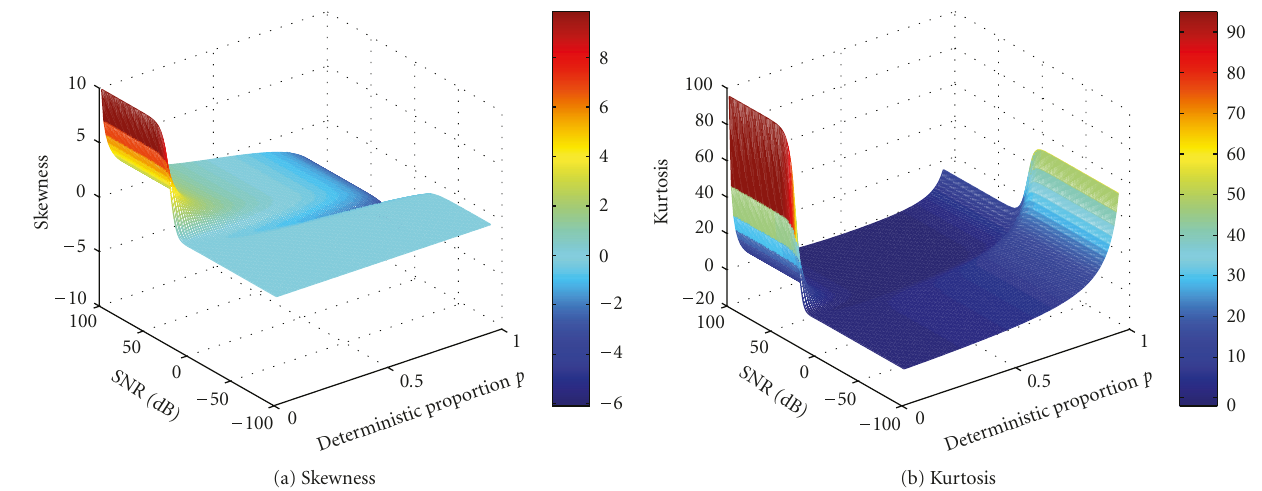
Figure 2: HOS in function of the deterministic proportion p and the SNR.